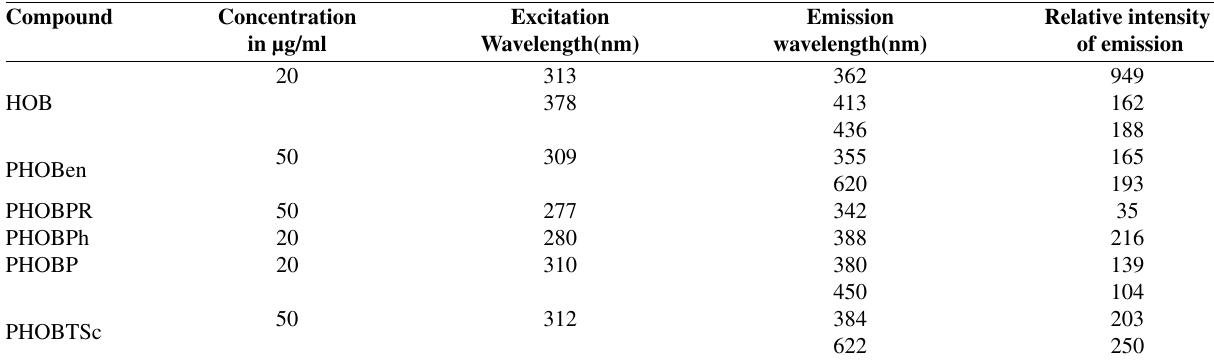
Table 2: Spectrofluorometric determination of monomer (HOB) and polymers. Compound